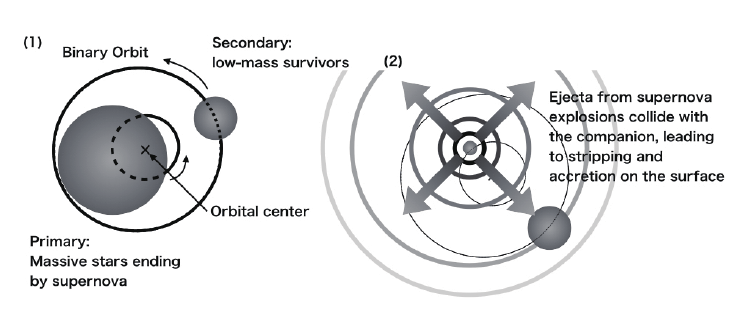
Figure 1. Schematic picture of our massive binary scenario to predict the survivors of the first stars in the Galactic